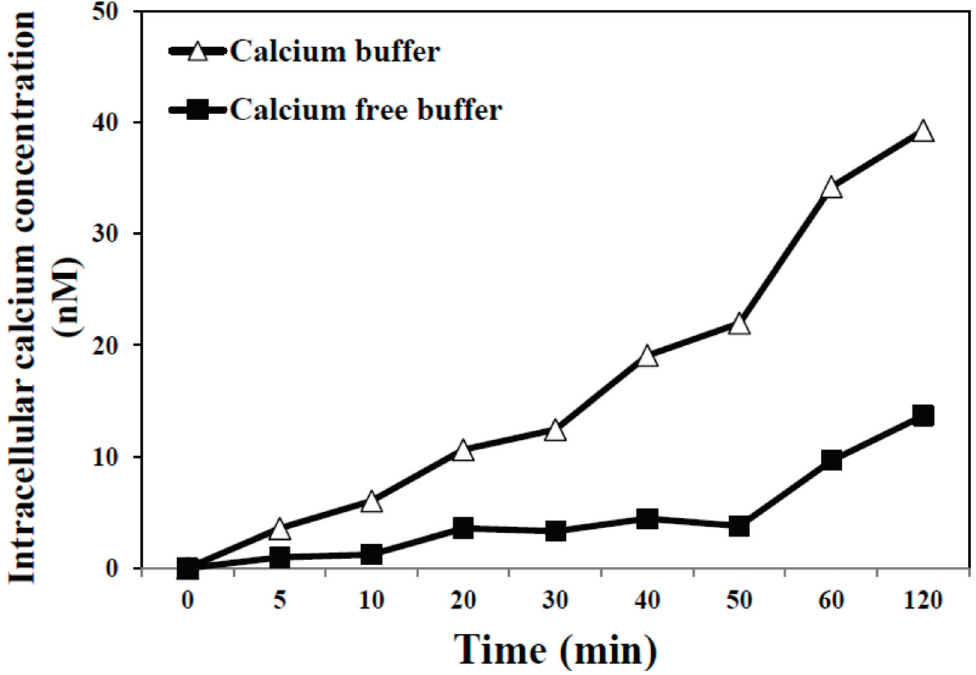
Figure 6. Intracellular calcium levels in CaCo-2 cells exposed to CaAl-LDH nanomaterials, measured by Calcium Green™-1.